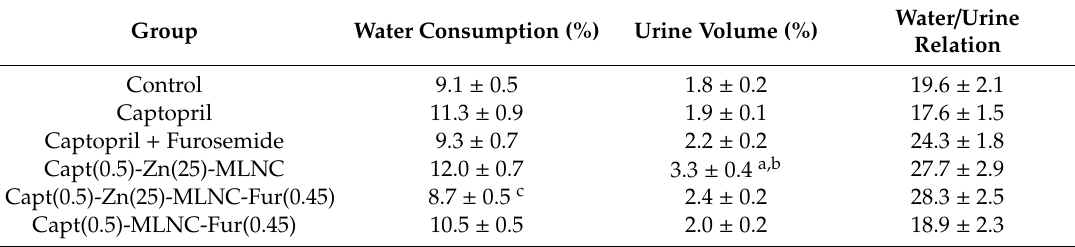
Table 1. Relative water consumption, urine volume and urine / water relation of spontaneously hypertensive rats (SHR) after 5 days of oral treatment (8 mL kg − 1 ) with solutions or formulations ( n = 6). The animals were kept in metabolic cages for 12 h. Values are expressed as mean ± SEM. Data were analyzed by ANOVA / Bonferroni. Group Water Consumption (%) Urine Volume